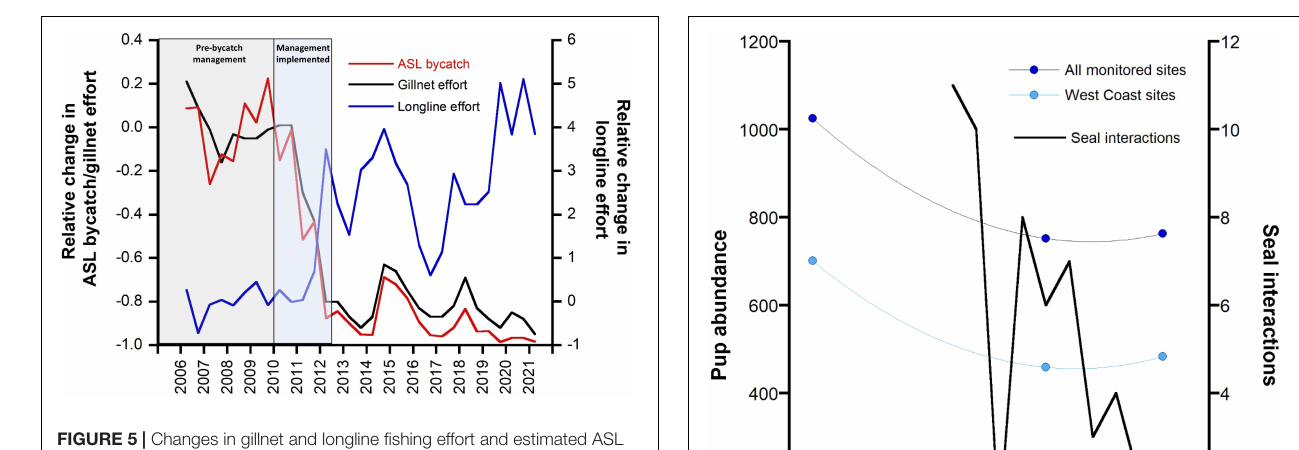
FIGURE 5 | Changes in gillnet and longline fishing effort and estimated ASL bycatch relative to average pre-management levels (2006–2009, inclusive) in the GHAT fishery off South Australia. Time periods are highlighted for before and after implementation of bycatch management.